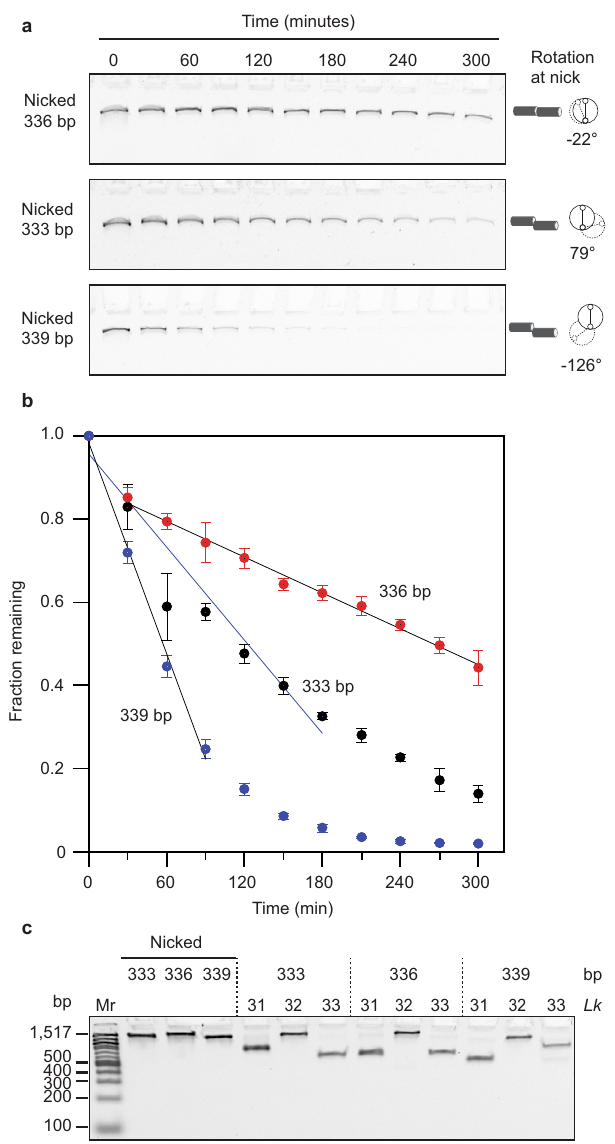
Fig. 2 Base exposure in nicked DNA depends upon DNA phasing. a 336, 333, or 339 bp minicircle DNA, previously nicked by Nb.BbvCI, was incubated with Bal-31. At the times indicated, samples were removed, quenched by the addition of stop buffer, and analyzed by polyacrylamide gel electrophoresis. Diagrams to the right of each gel show the predicted rotational alignment of the DNA ends on either side of the nick site. Uncropped gel images are provided in Source Data. b The fraction of nicked DNA remaining over time in ( a ) was quanti fi ed. The assay was repeated three times and mean values are shown. Error bars represent standard deviations. The data were fi tted to a linear slope, excluding the later timepoints for the 333 bp and 339 bp minicircles that deviated from the linear relationship. c Relative electrophoretic mobility of minicircle topoisomers to determine Lk 0 . The polyacrylamide gel was run under conditions replicating Bal-31 reaction conditions (600 mM NaCl, 12 mM CaCl 2 , 12 mM MgCl 2 ). This assay was performed one